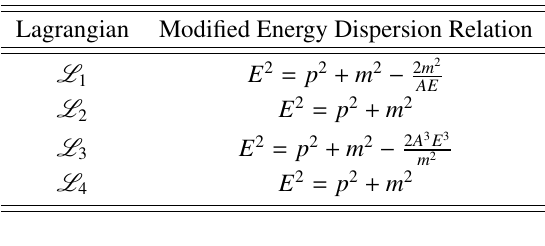
Table 1. Modified energy dispersion relations from our constructed generalised Dirac Lagrangians.